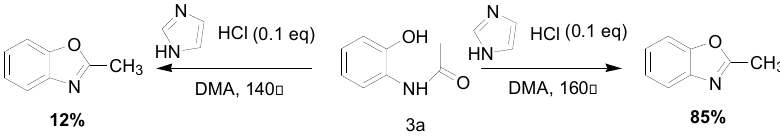
Table 4. Substrate scope with respect to substituted 2-aminothiophenols a.